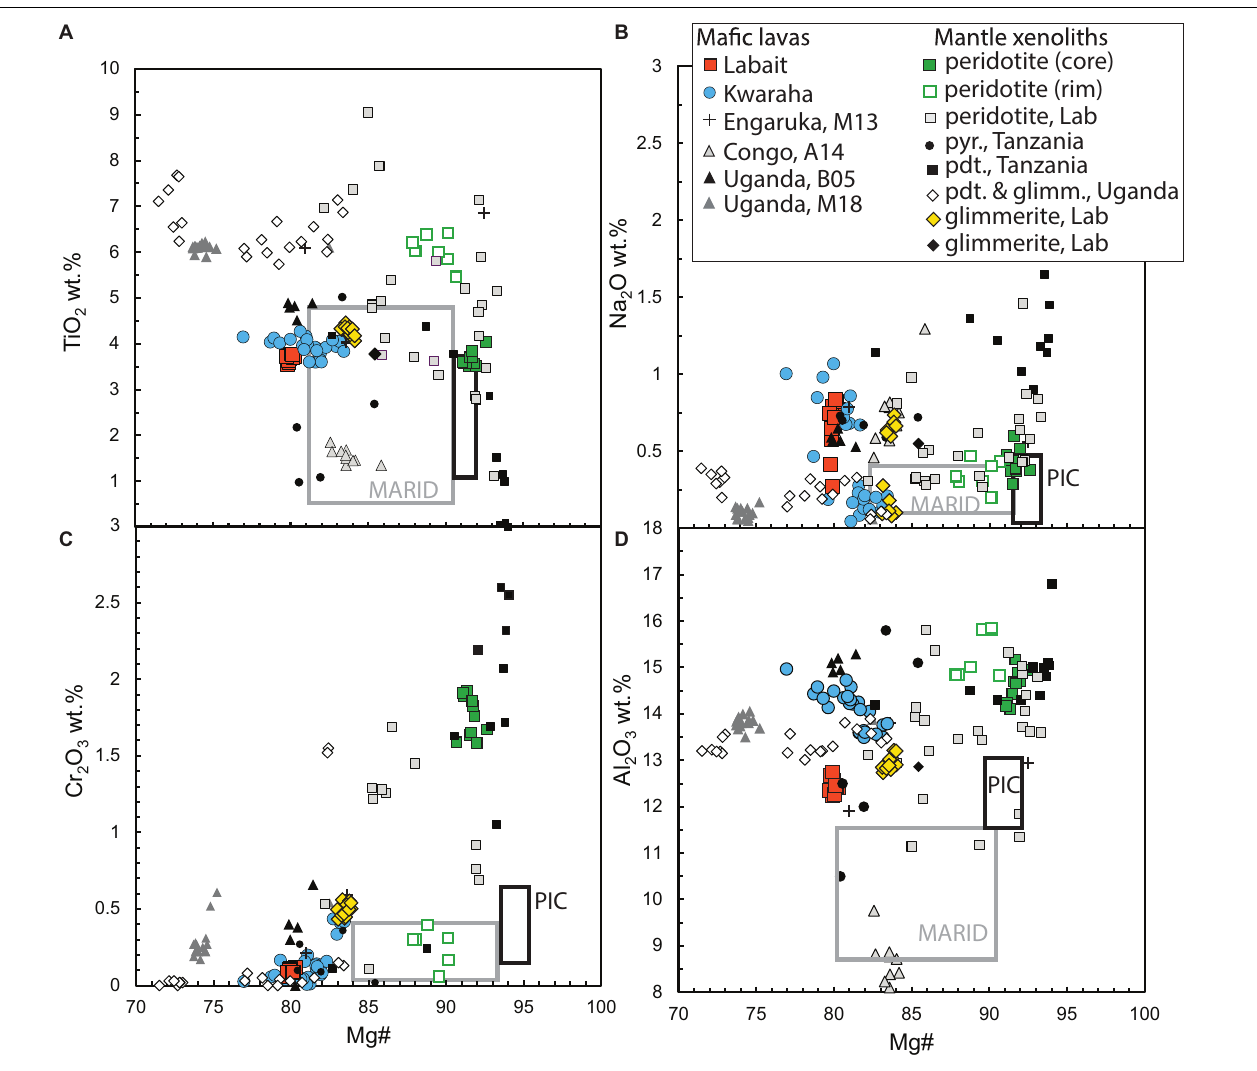
FIGURE 6 | Phlogopite compositions (A) TiO 2 (B) Na 2 O, (C) Cr 2 O 3 and (D) Al 2 O 3 vs. Mg# from Kwaraha (blue circles) and Labait lavas (orange close squares), and glimmerite (Labx7, orange diamonds) and lherzolite xenoliths (Labx6, open orange squares). Literature data are also reported for lavas from: Engaruka (Tanzania; Mattsson et al., 2013); Nyiragongo volcano (Congo; Andersen et al., 2014); Fort Portal (Uganda; Bailey et al., 2005); Bunyaruguru volcanic field (Uganda; Muravyeva and Senin, 2018) and xenoliths from Labait (Tanzania; Lee and Rudnick, 1999; Koornneef et al., 2009) and north Tanzania (Dawson and Smith, 1988, 1992) and from Bunyaruguru volcanic field (Uganda; Muravyeva and Senin, 2018). Gray and black rectangles for phlogopite composition in MARID and PIC, respectively, from Dawson and Smith (1977); Jones et al. (1982), Kramers et al. (1983); Waters (1987), and Grégoire et al. (2002). Lab: Labait; pyr: pyroxenite; pdt: peridotite.